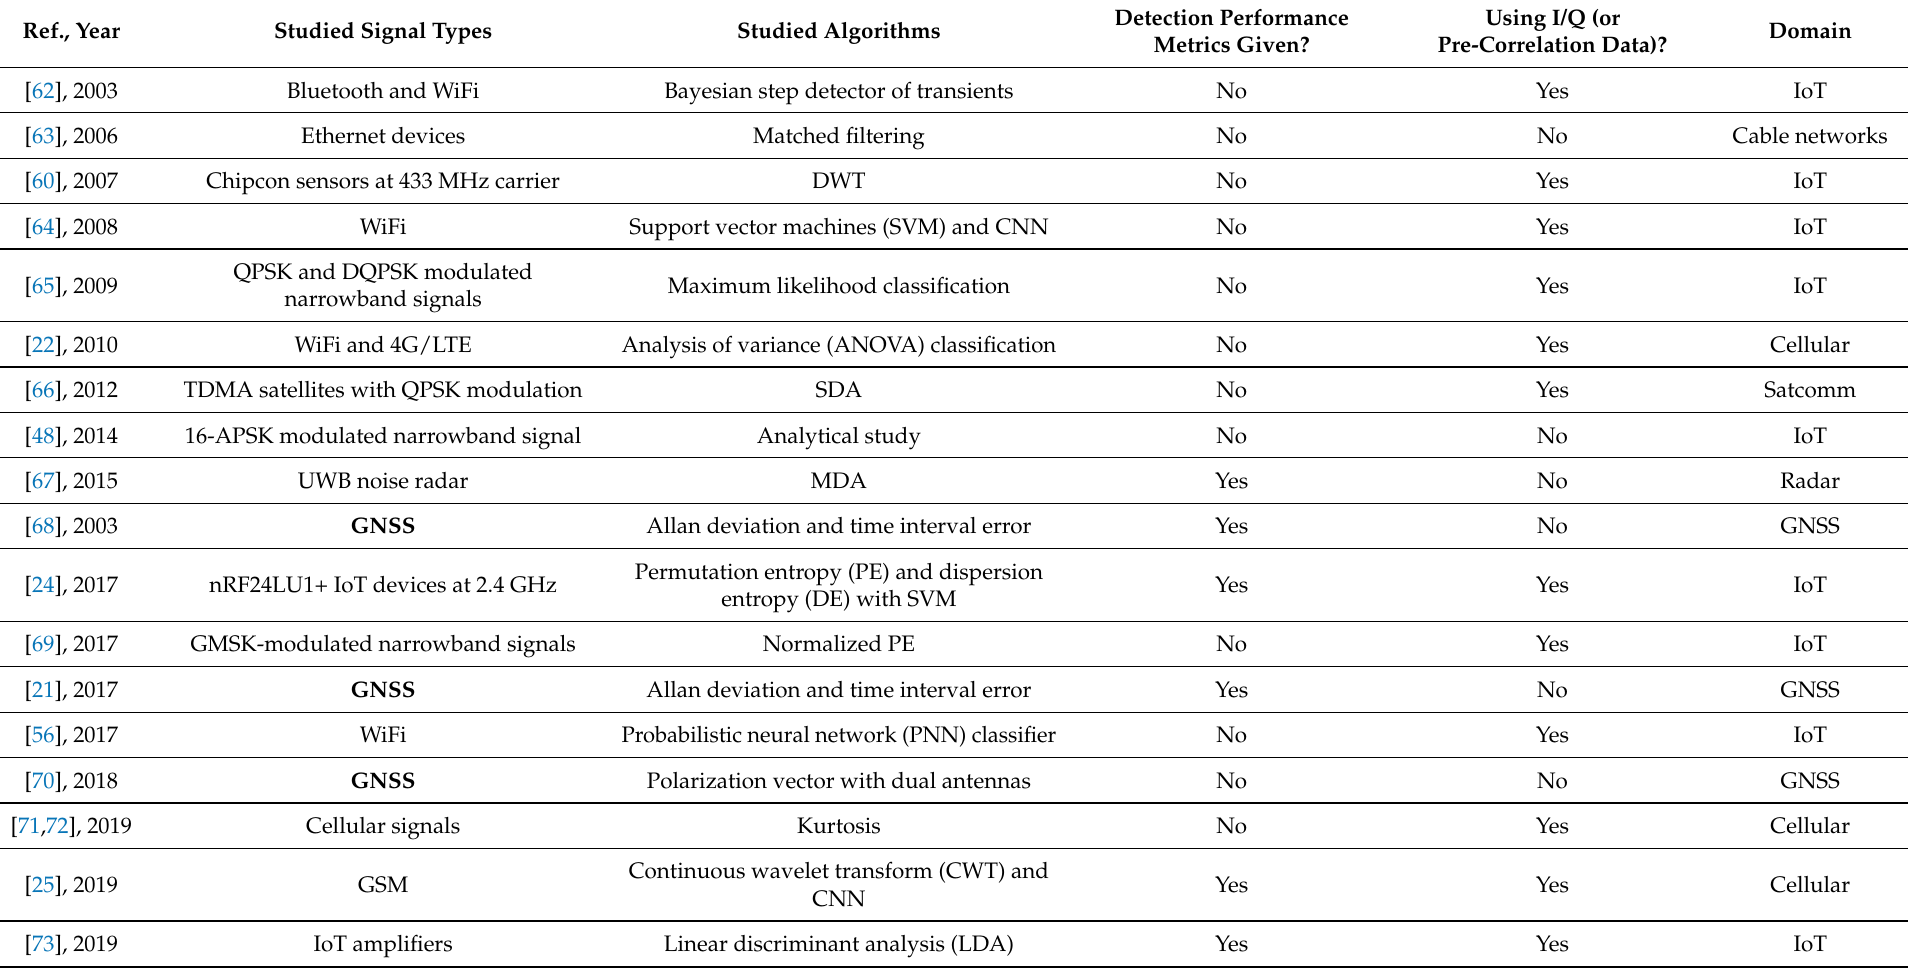
Table 1. Overview of state-of-the-art: RFF-related studies based on pre-correlation data, for wireless communications, and navigation applications. Ref.,